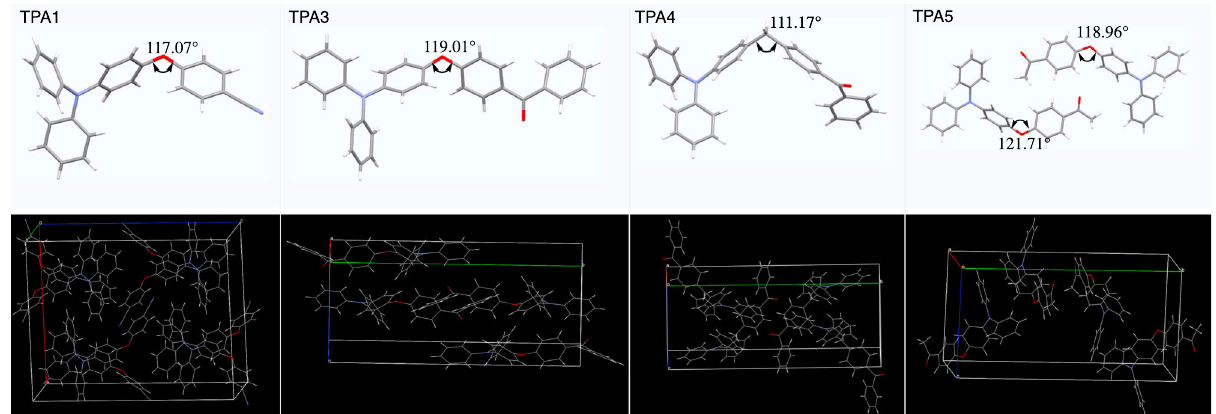
Fig. 3 Single-crystal XRD analysis. Stick models (top) of TPA1 and TPA3 – 5 obtained from single-crystal XRD measurements and packing diagrams shown in wireframe model (bottom), indicating no obvious strong π – π intermolecular interactions in the solid